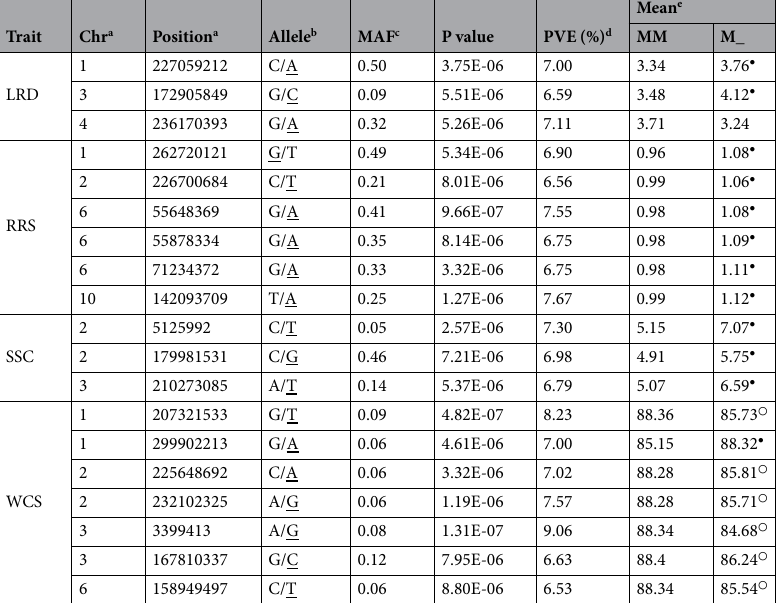
Genome-wide association mapping for the four chilling tolerance traits. Single nucleotide pol- ymorphism (SNP) genotyping of the inbred lines (including Mo17) was conducted in a previous study 19 , and 556,809 high-quality SNPs with minor allele frequencies greater than 0.05 were present in the association map- ping panel. In the entire population, a total of 19 significant SNP-trait associations were identified for the four traits with a threshold of P < 9.0 × 10 − 6 , and individual significant SNP explained 6.53% to 9.06% of phenotypic variation (Table 2). These SNPs were distributed on chromosome 1, 2, 3, 4, 6, and 10. At 12 of the 19 significant loci heterozygous alleles had positive effects, and at six of the loci the trait means in genotypes with heterozygous alleles were similar to the trait means in genotypes with homozygous alleles (Table 2). The 338 inbred lines used for producing the testcrossing hybrids can be divided into the stiff stalk (SS), non-stiff stalk (NSS), and tropical-subtropical (TST) subpopulations according to a previous study 19 . Inbred lines in the first two subpopulations are temperate maize from two different heterotic groups. A total of 2, 10, and 1 significant loci for the four traits were revealed within the three subpopulations at the threshold of P < 1.810–6, respectively (Table 3). Individual locus explained 0.86–13.93% of phenotypic variation. In the SS subpopulation, the SNP (chr1: 53, 174, 087) was significantly associated with both LRD and RRS. Of the significant SNPs identi- fied in the NSS subpopulation, the SNP (chr2: 1, 317, 451) was related to both SSC and WCS, and the locus (chr8: 82, 060, 785) simultaneously controlled LRD and RRS. At 10 of the 13 significant loci genotypes, heterozygous alleles had higher or similar trait means compared to the genotypes with homozygous alleles (Table 3). Candidate genes predicted according to the significant loci. The overall linkage disequilibrium (LD) decay distance was 50–100 kb when the r 2 cut-off value was set as 0.2 19 ; thus, the candidate genes were predicted within the extension regions ranging from 50 kb upstream to 50 kb downstream of the significant SNPs. A total of 59 and 35 annotated genes were predicted according to the 19 and 13 loci identified by the entire population and subpopulations, respectively. Of these genes, 36 are putatively related to stress tolerance according to previous reports. These stress-related candidate genes can be classified into four categories according to their function. Detailed information for these genes is summarized in Supplemental Tables S1 and S2. The first gene category includes four transcription factors and seven signal transduction genes. All of the candidate genes were predicted according to the loci identified from the entire population. GRMZM2G110242 encodes a TEOSINTE BRANCHED/CYCLOIDEA/PCF (TCP) family transcription factor. Yang et al . 20 found that down-regulating some TCPs enhanced cold tolerance in rice. Auxin responsive factors (ARFs) regulate the expression of auxin-responsive genes. ARF3 (a GRMZM2G437460 homolog) and ARF4 were down-regulated by abiotic stresses and co-expressed with twenty-five abiotic stress-related genes 21 . Vascular plant One Zinc-finger proteins (VOZs) are plant-specific transcription activators. Loss-of-function mutations in VOZ1 and VOZ2 (a GRMZM2G111696 homolog) increased cold and drought tolerance, and overexpression of VOZ2 impaired freez- ing and drought tolerance in Arabidopsis 22, 23 . GRMZM2G110085 encodes a casein kinase 1 (CK1) protein. The CK1 family plays central roles in cellular stress-responses and carcinogenesis in animals 24 . GMZM2G159756